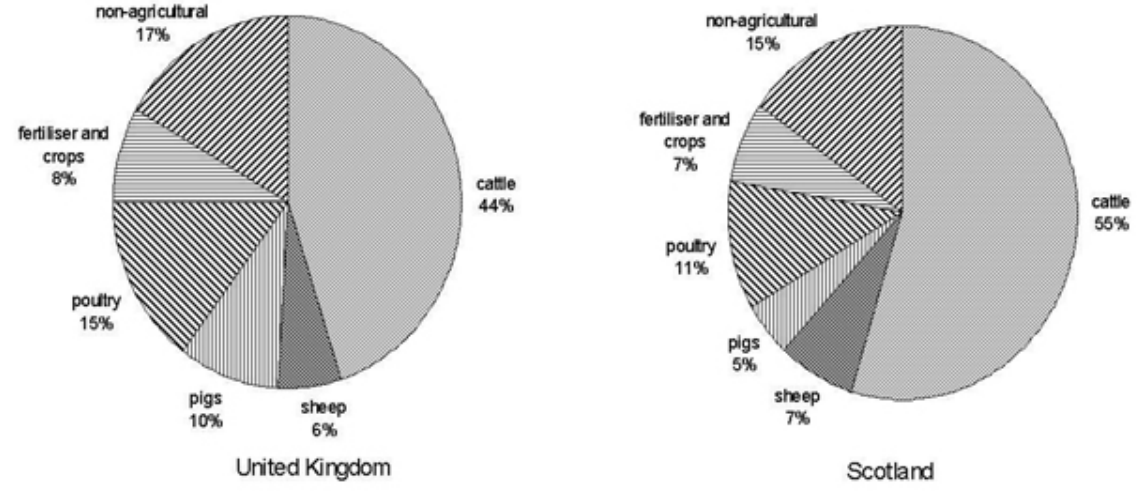
FIGURE 3. Sources of ammonia emissions in the U.K. and Scotland (for 1996, other recent years are